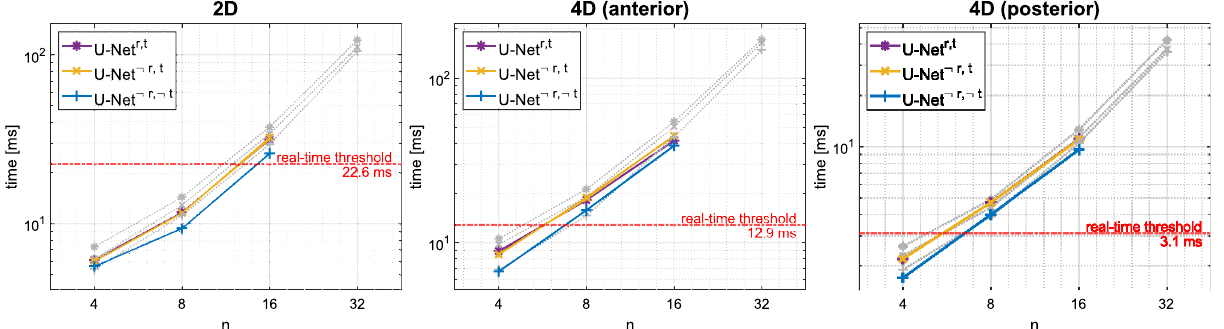
Figure 5. System and benchmark per-buffer denoising times for the three different imaging modes. All colored times, including the thresholds, were determined by profiling of the OCT software. Gray data points represent benchmark timings. For stable operation, processing times must be considerably lower than the real-time threshold, which is the available idle time of the GPU during reconstruction. Especially the omission of the top- skip of the U-Net increased the inference